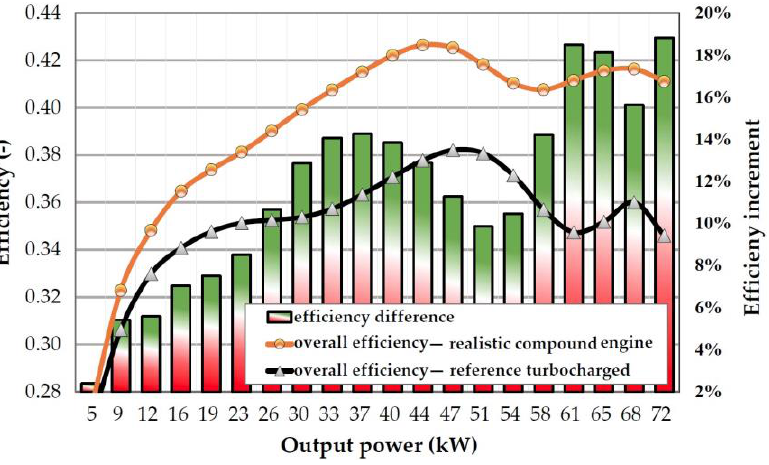
Figure 16. Comparison between the best efficiency curves of the realistic compound engine compared to the reference traditional turbocharged engine.